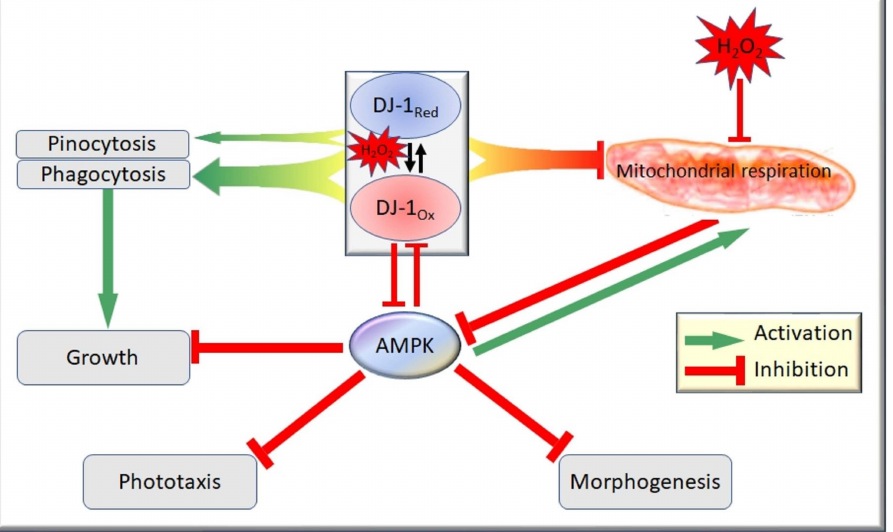
Figure 1. Model for phenotypic consequences of interactions between DJ-1, AMPK, mitochondrial respiration and oxidative stress. Mitochondrial respiration is inhibited separately by oxidative stress and DJ-1, both in its oxidized (DJ-1 Ox ) and reduced (DJ-1 Red ) states (indicated by the bifurcated base of the arrow). DJ-1 also activates phagocytosis (broad arrow) and to a slight extent (narrower arrow) pinocytosis, regardless of its oxidation state (indicated by the bifurcated base of the arrows). DJ-1 Ox , but not DJ-1 Red , inhibits and is inhibited by AMPK. Under oxidative stress mitochondrial respiration is inhibited, ATP production is compromised and AMPK is activated, by oxidative stress both directly (not shown) and via the impaired mitochondrial function. At the same time, DJ-1 is oxidized and inhibits AMPK, opposing the effects of impaired respiration and protecting cells from the downstream phenotypic consequences of chronic AMPK hyperactivity. Reproduced from Chen et al. 2021